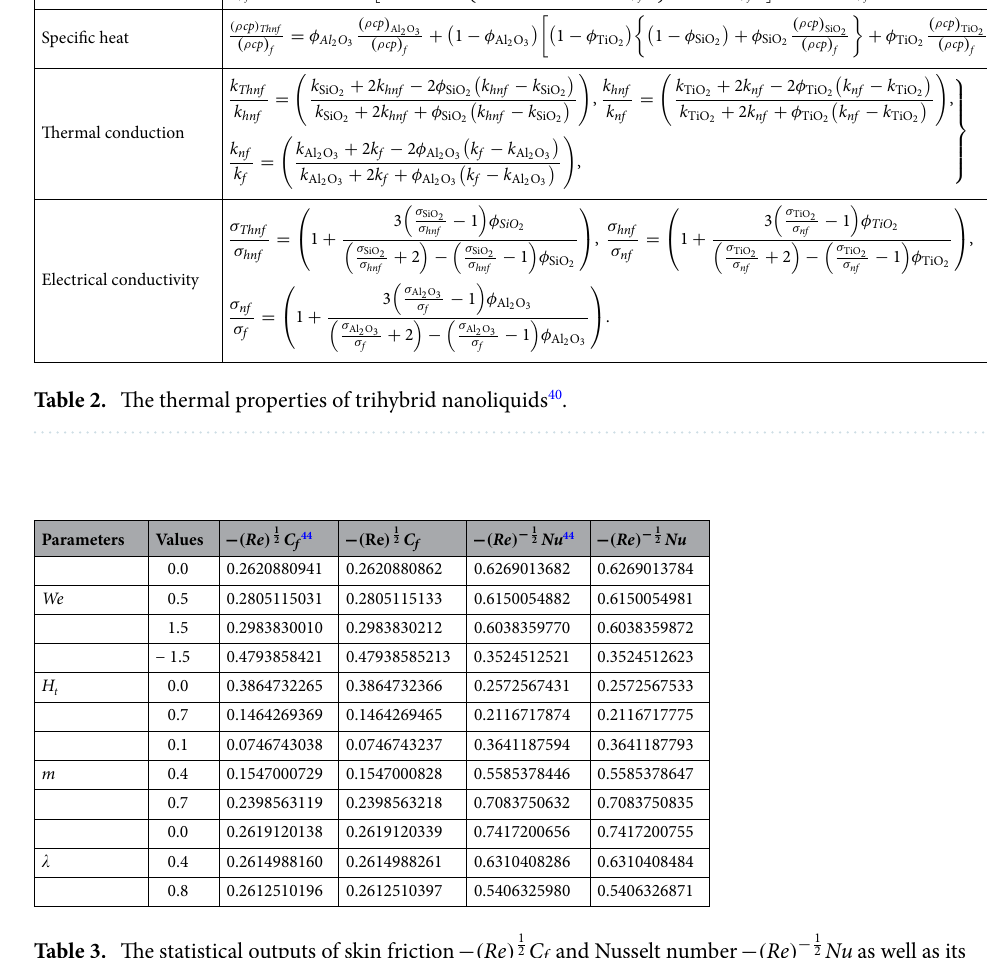
( Re ) − 1 2 Nu as well as its −